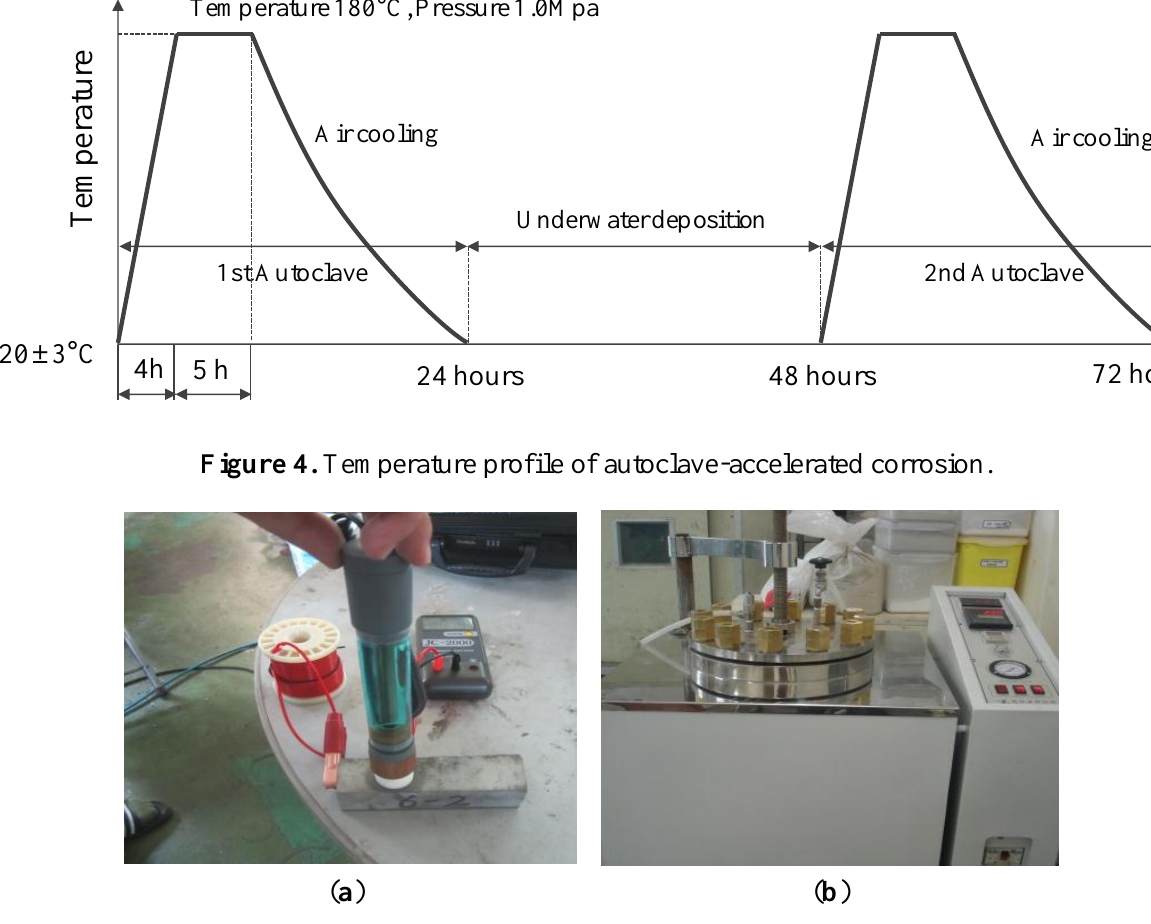
Figure 5. Procedures for testing the anti-corrosion characteristics. ( a ) Measurement of the corrosion potential; ( b ) Accelerated corrosion by